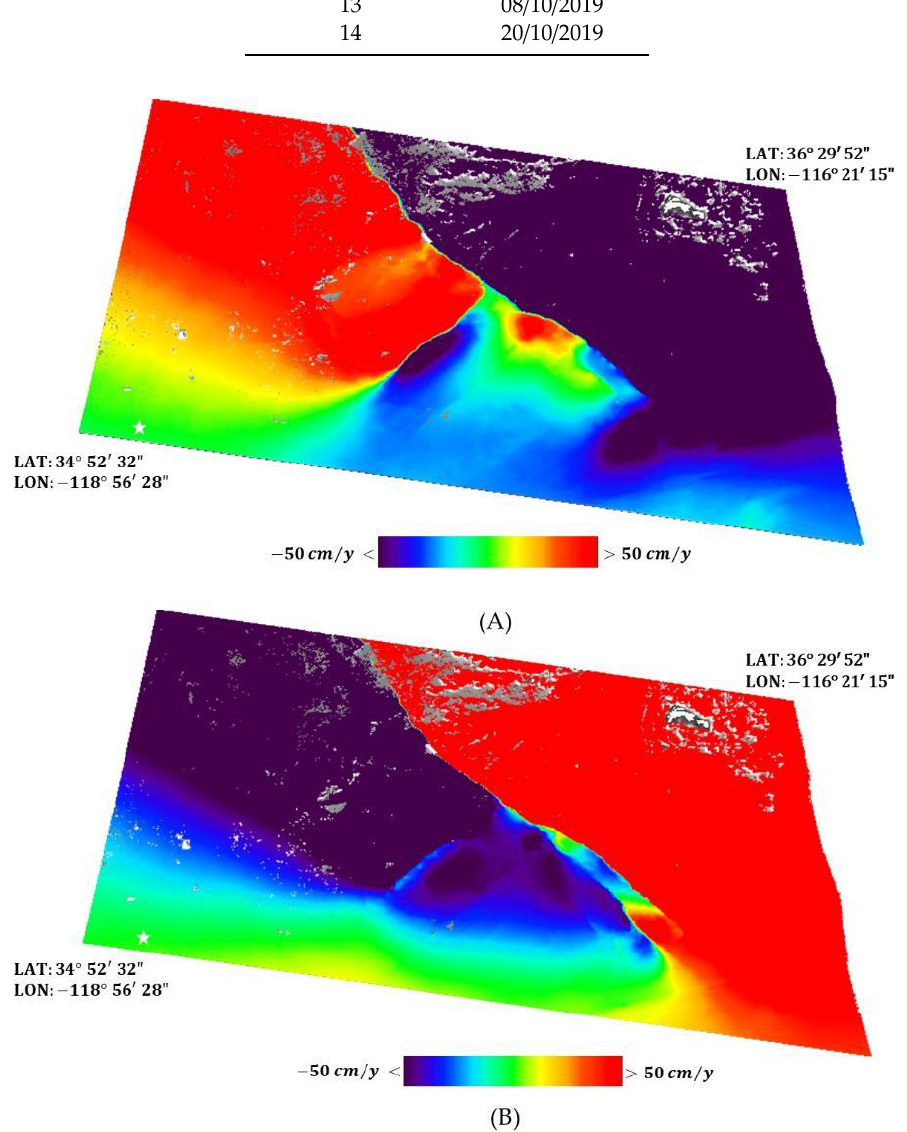
Figure 24. Geocoded LOS-projected mean displacement maps of the Ridgecrest area, superimposed on an amplitude image for ascending (A) and descending (B) orbits, respectively. All the displacement measurements are evaluated with respect to a pixel, identified in (A) and (B) by a white star. Subsequently, the MinA combination technique was applied to the two sets of geocoded data, to decompose the LOS-projected deformation measurements along the east–west and up–down directions, as shown in Figure 25A,B, respectively